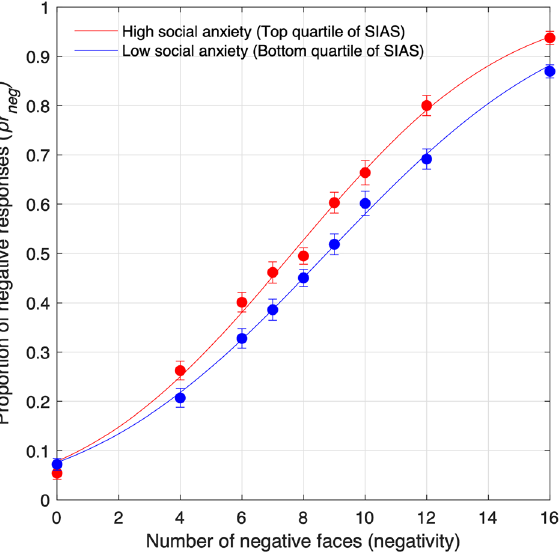
Figure 2. Proportion of negative responses (pr neg ) in high and low social anxiety groups. The means (circles) were plotted as a function of the number of angry faces (negativity) along with fitted psychometric curves (solid lines). Error bars represent